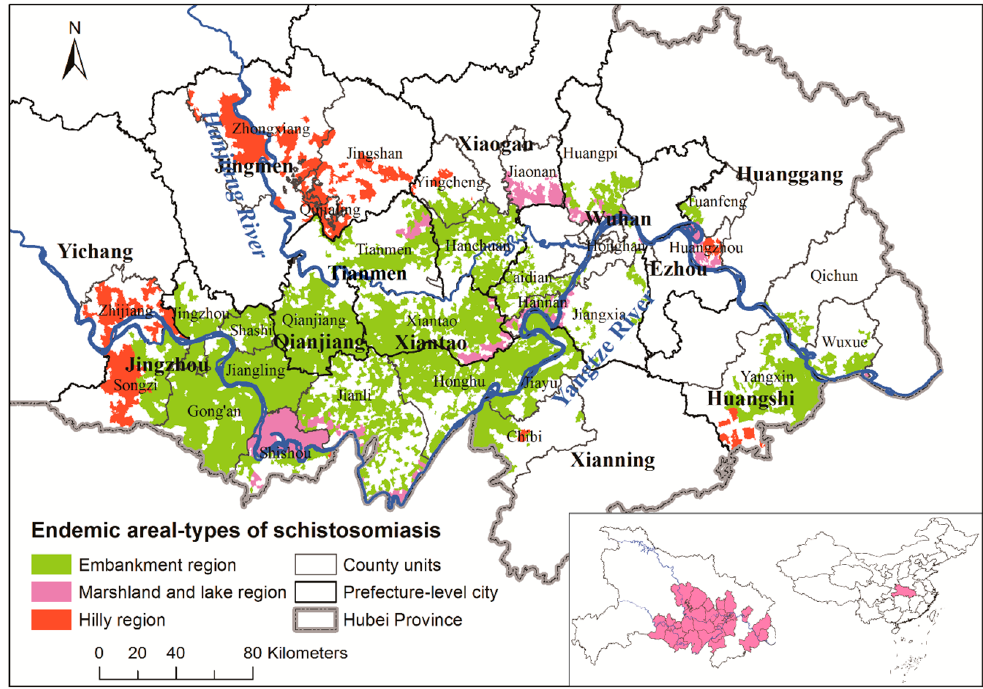
Figure 1. Study area and epidemic areal-types of schistosomiasis. The inset shows the location of the 30 most endemic counties in Hubei and in China. The geographical layers of Yangtze and Han Rivers are overlaid.